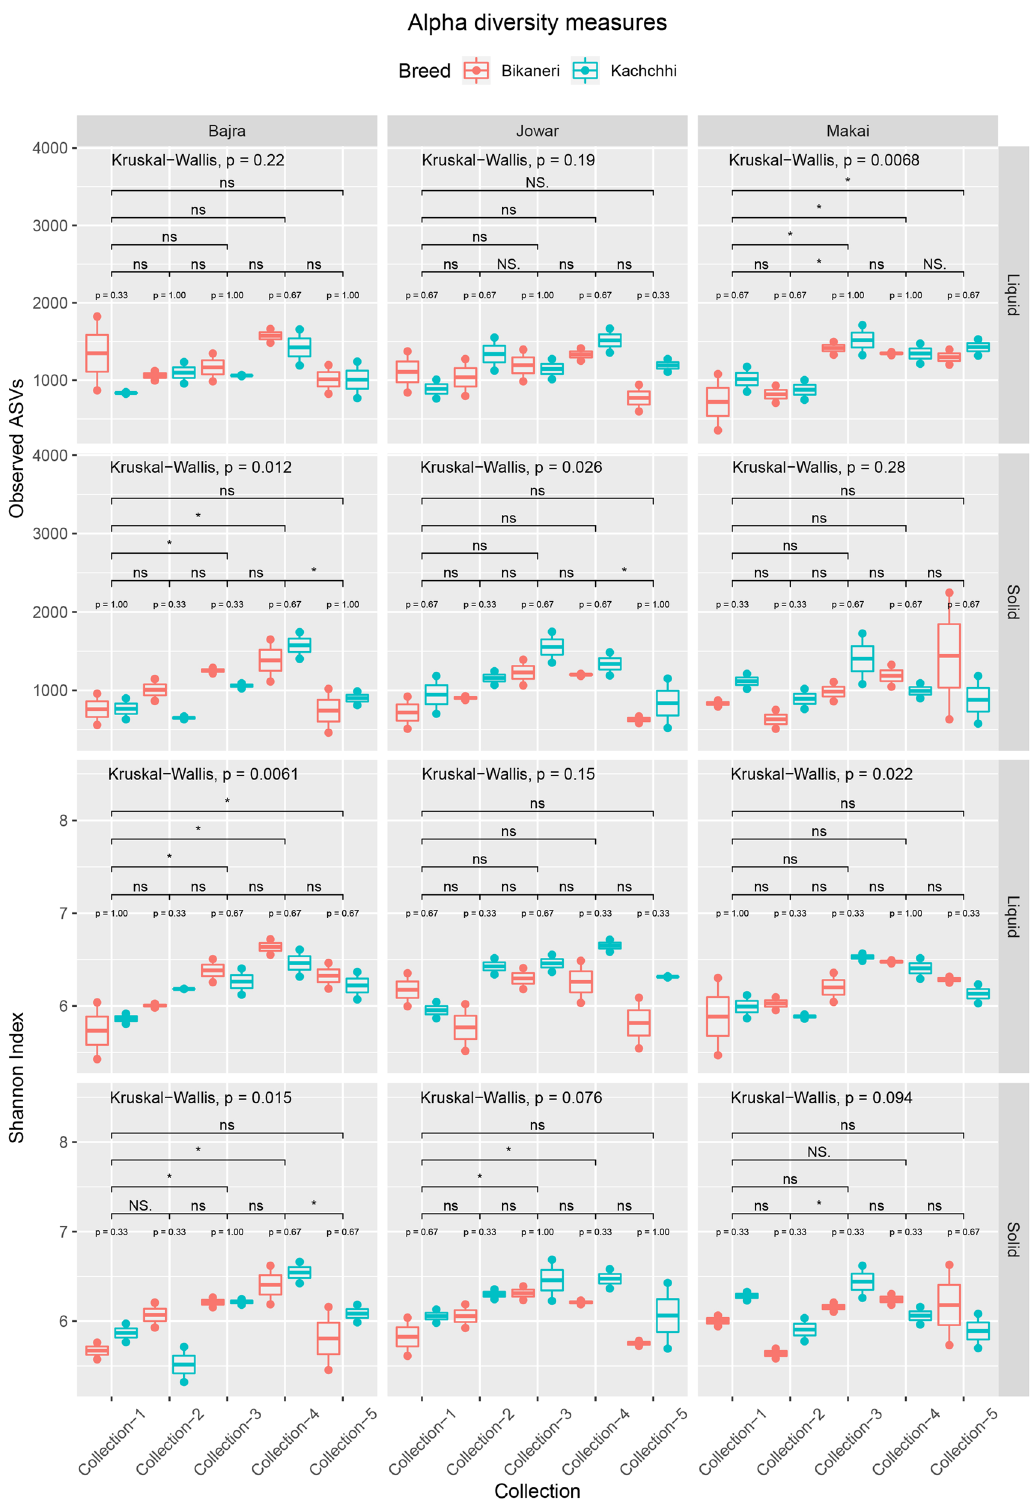
Figure 1. Alpha diversity measures (Observed ASVs, top and Shannon Index, bottom) distribution among all samples. Samples are colored by breed and separated based on feed and fraction. Wilcoxon test comparison between breeds are mentioned as “p = ” above the box-plots. Bars with p-value (*** < 0.001 < ** < 0.01 < * < 0.05; ns = not significant) mentioned above represents p-value from pairwise comparison of different Collections using Wilcoxon test. Kruskal–Wallis comparison among all the samples within same fraction and same feed is mentioned on the top of every